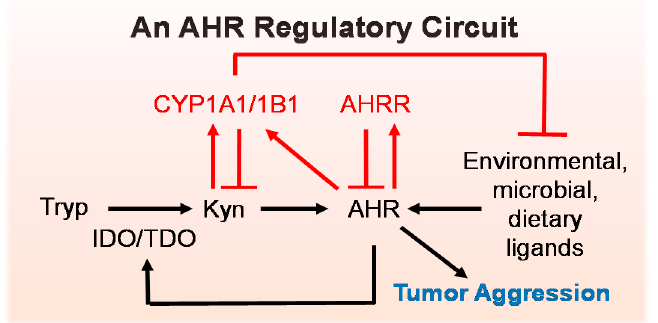
Figure 4. AHR Regulatory Circuit. Tryptophan is metabolized to Kynurenine (Kyn) and downstream AHR ligands that drive AHR activity and cancer aggression (migration, invasion, metastasis, “stem-ness”). Activated, nuclear AHR upregulates Ido1 , Ido2 , and/or Tdo2 , producing more AHR ligands in an amplification loop that sustains AHR activity. AHR induces CYP1A1 and CYP1B1 (hydroxylases that can metabolize some AHR ligands) and AHR repressor (which limits AHR activity). Environmental, microbial or dietary AHR ligands may “prime the pump” and/or exacerbate the endogenous AHR signaling circuit.